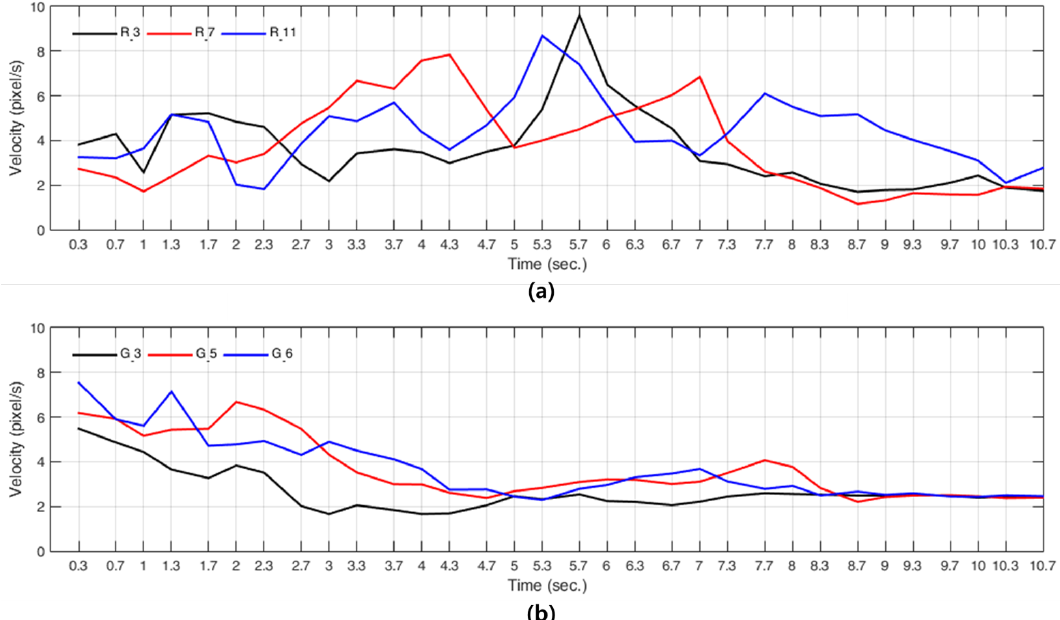
Figure 10. Time series for the estimated velocities of 6 landmarks indicated in the leftmost image of Figure 8: ( a ) velocity of tracked waves at the R_3, R_7, and R_11 and ( b ) velocity of tracked waves at the G_3, G_5, and